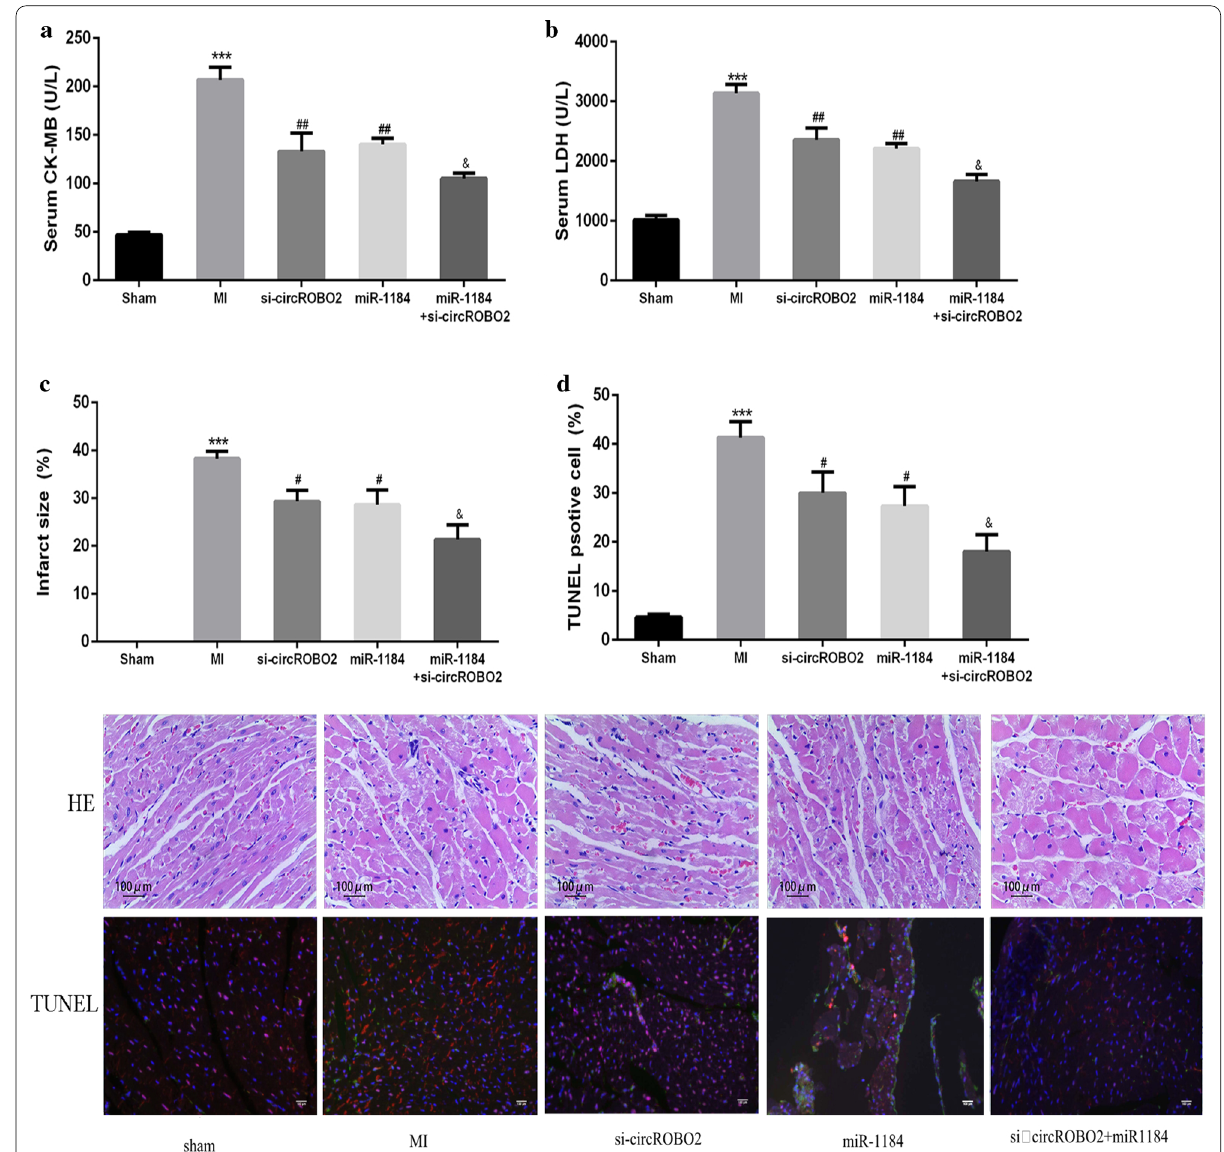
Fig. 6 The effects of knockdown of circROBO2 on myocardial injury. Sham, MI, si‑circROBO2, miR‑1184 and si‑circROBO2 CK‑MB ( a ) and LDH ( b ) and myocardial infarction size ( c ) were detected and compared. All above the experiments were repeated 3 times. * vs normoxia control group, # vs si‑NC group, &vs si‑circROBO2 group. *** P < 0.001, ## P < 0.01 and & P < 0.05. d HE staining and TUNEL/nkx2.5 co‑staining to detect the apoptosis of mouse cardiomyocytes. The red signaling indicate TUNEL, green signaling indicate nkx2.5, Scale bar: 100